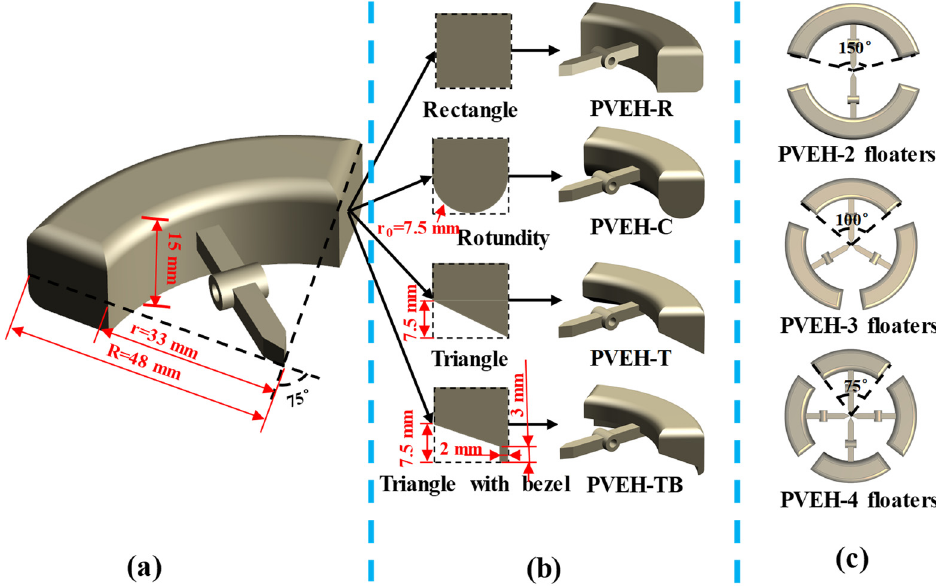
Figure 3. ( a ) Fan-shaped ring hollow floating block with lever; ( b ) floating blocks of different bottom shapes; ( c ) floating blocks with different array distributions.